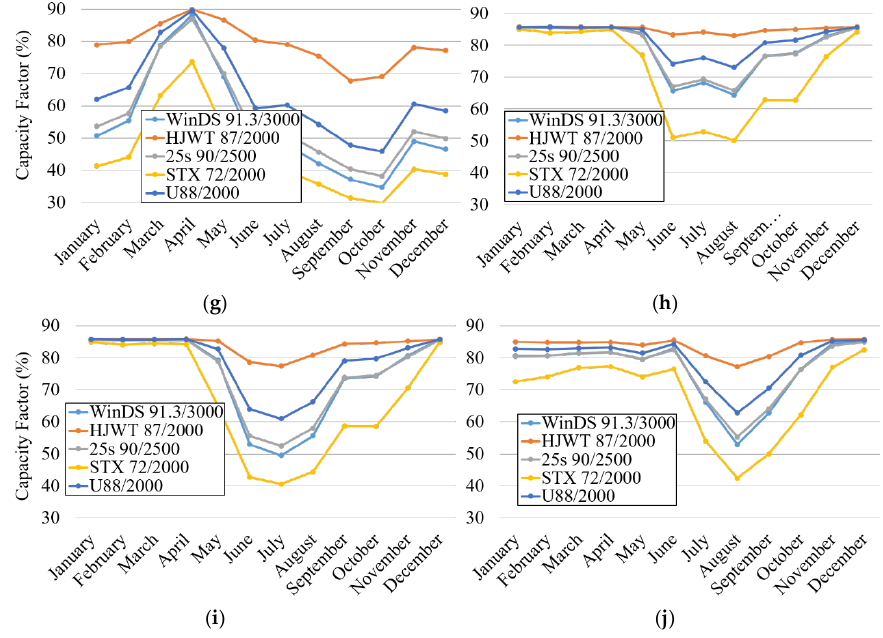
Figure 12. Estimation of CF at newly proposed wind farm sites ( a ) Site 1 ( b ) Site 2 ( c ) Site 3 ( d ) Site 4 ( e ) Site 5 ( f ) Site 6 ( g ) Site 7 ( h ) Site 8 ( i ) Site 9 ( j ) Site 10 .